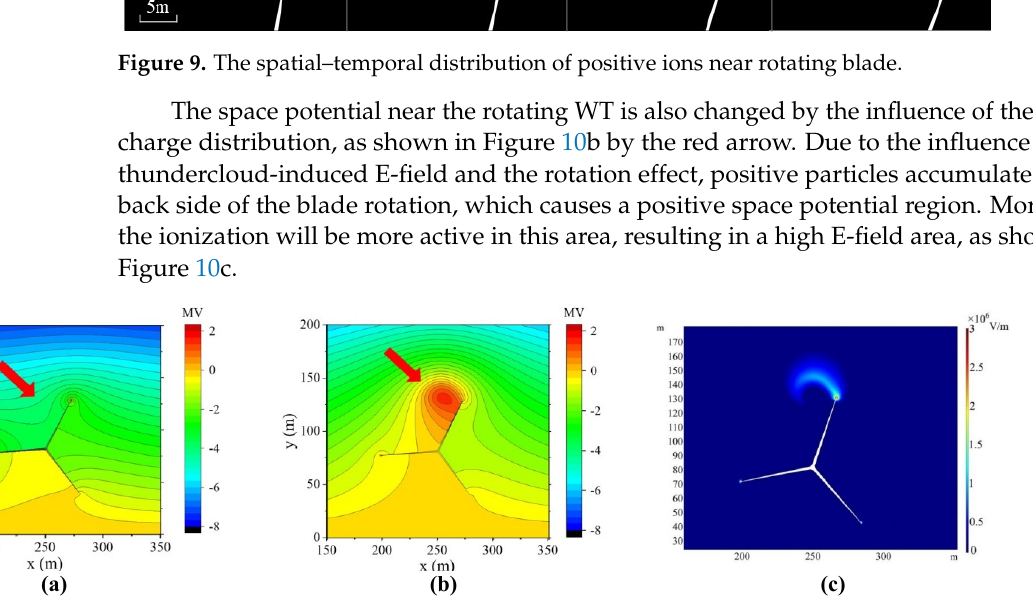
Figure 10. The characteristics of E ‐ field near rotating blade: ( a ) the potential contour without con ‐ sidering space charge, ( b ) the potential contour with space charge, ( c ) the E ‐ field with the influence of space